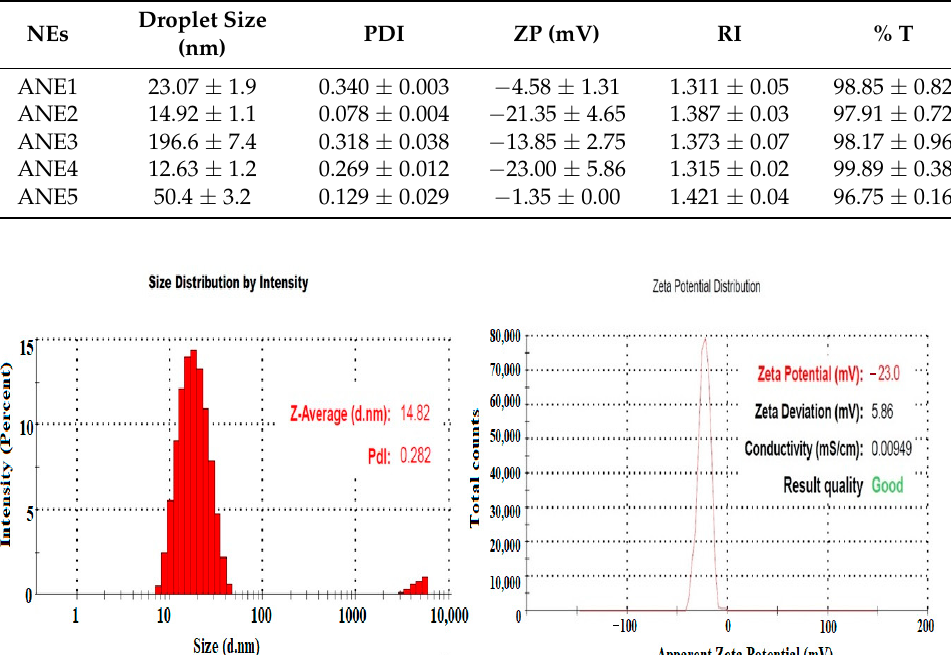
Table 1. Physico-chemical evaluation of APL-loaded NEs (ANE1-ANE5).